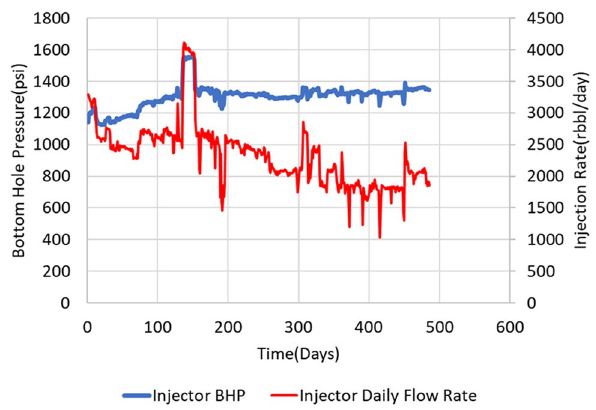
Fig. 6 BHP and CO